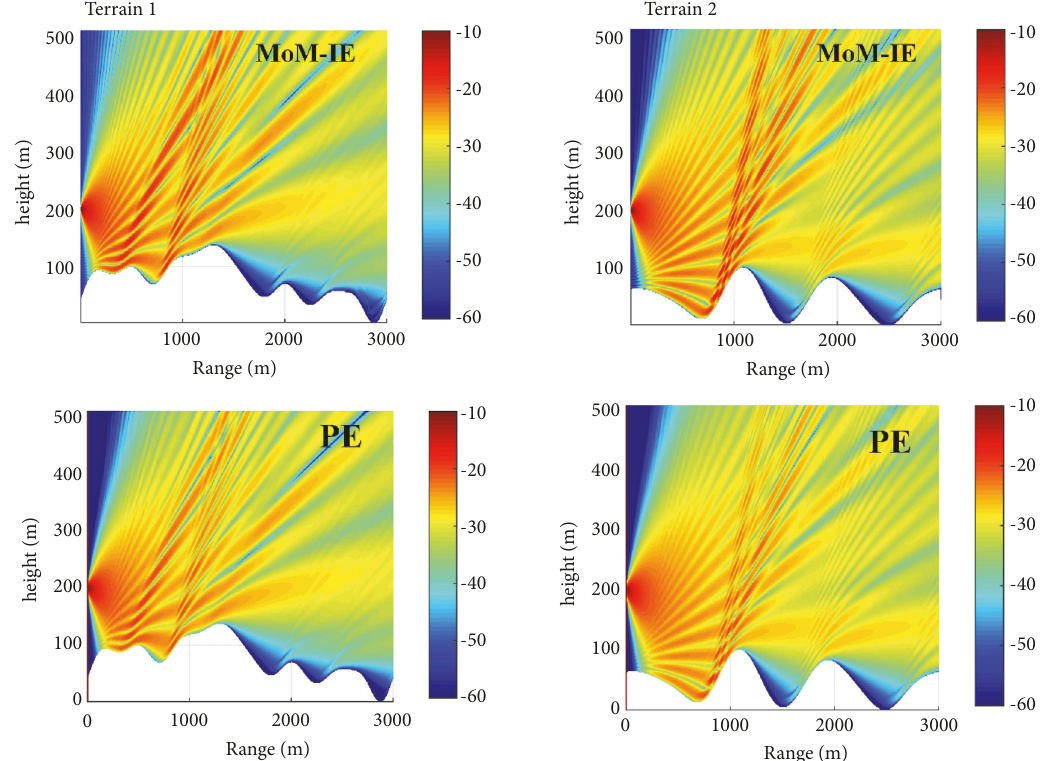
Figure 9: Field strength profiles in dB calculated via PE and IE method, respectively. The operating frequency of a horizontally polarized antenna is 30 MHz. The beam width is 20 ∘ , and the antenna height is 200 m.